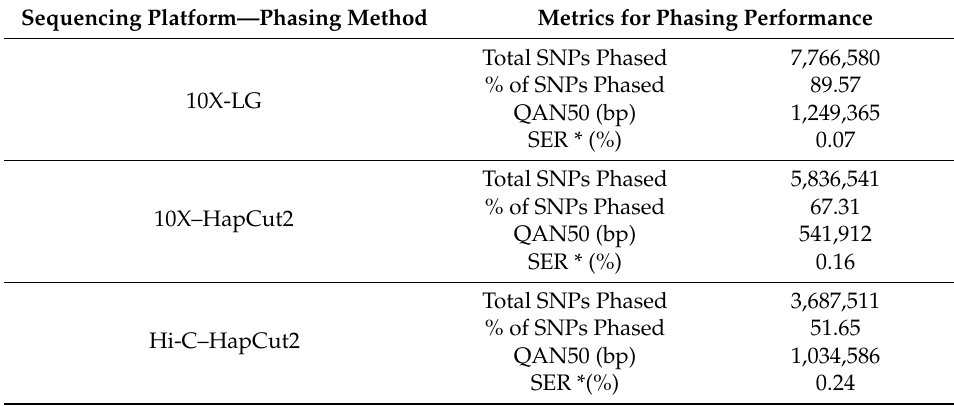
Table 3. Summary of phasing performance: Metrics shown are total number of SNPs phased, percentage of SNPs phased, Quality adjusted N50 (QAN50), and the switch error